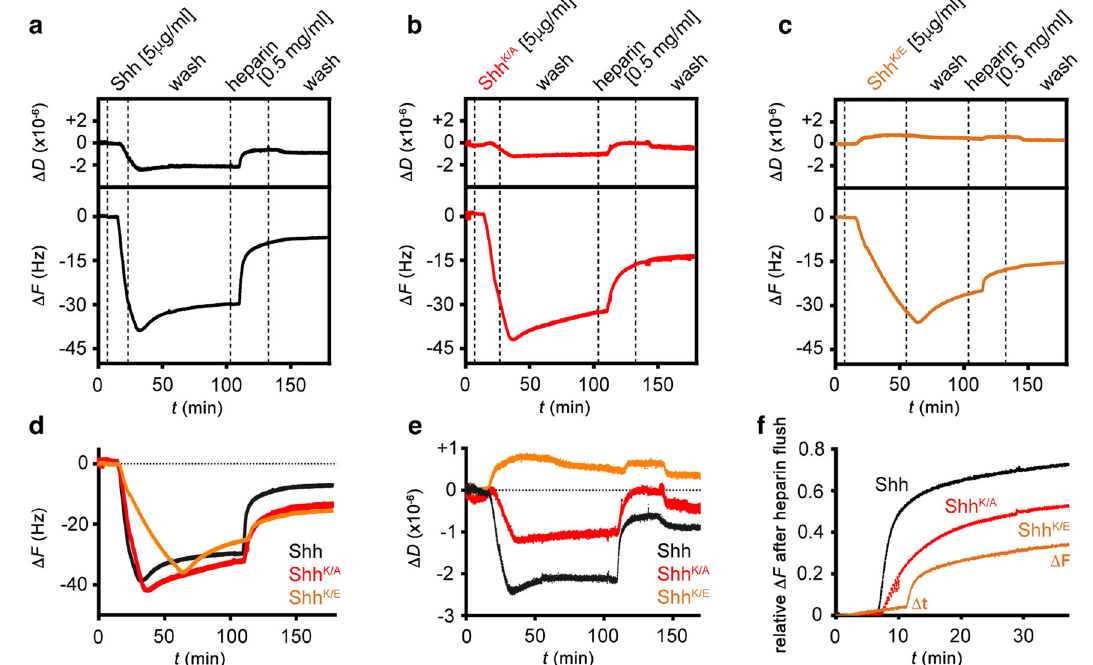
Fig.6|ThesecondHS-bindingsiteinShhfacilitatescross-linkingandswitching between heparins. a – c QCM-D binding assays analogous to Fig. 5, for Shh ( a ), Shh K/A ( b ), and Shh K/E ( c ), with an added step of competition with soluble heparin. d Overlays of frequency responses as shown in ( a – c ) demonstrate a reduced bindingrateandincreasedunbindingrateinthewashbufferofShh K/E ,andreduced unbinding of Shh K/A and Shh K/E upon competition with soluble heparin, compared to Shh. e Overlay of associated dissipation shifts as shown in ( a – c ) evidences